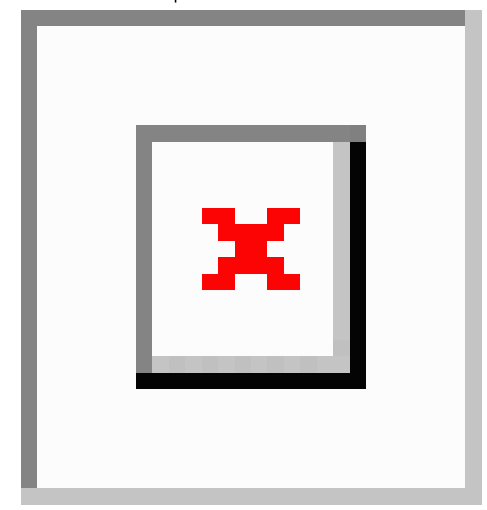
Figure 1. Mathematical expression of the Bass